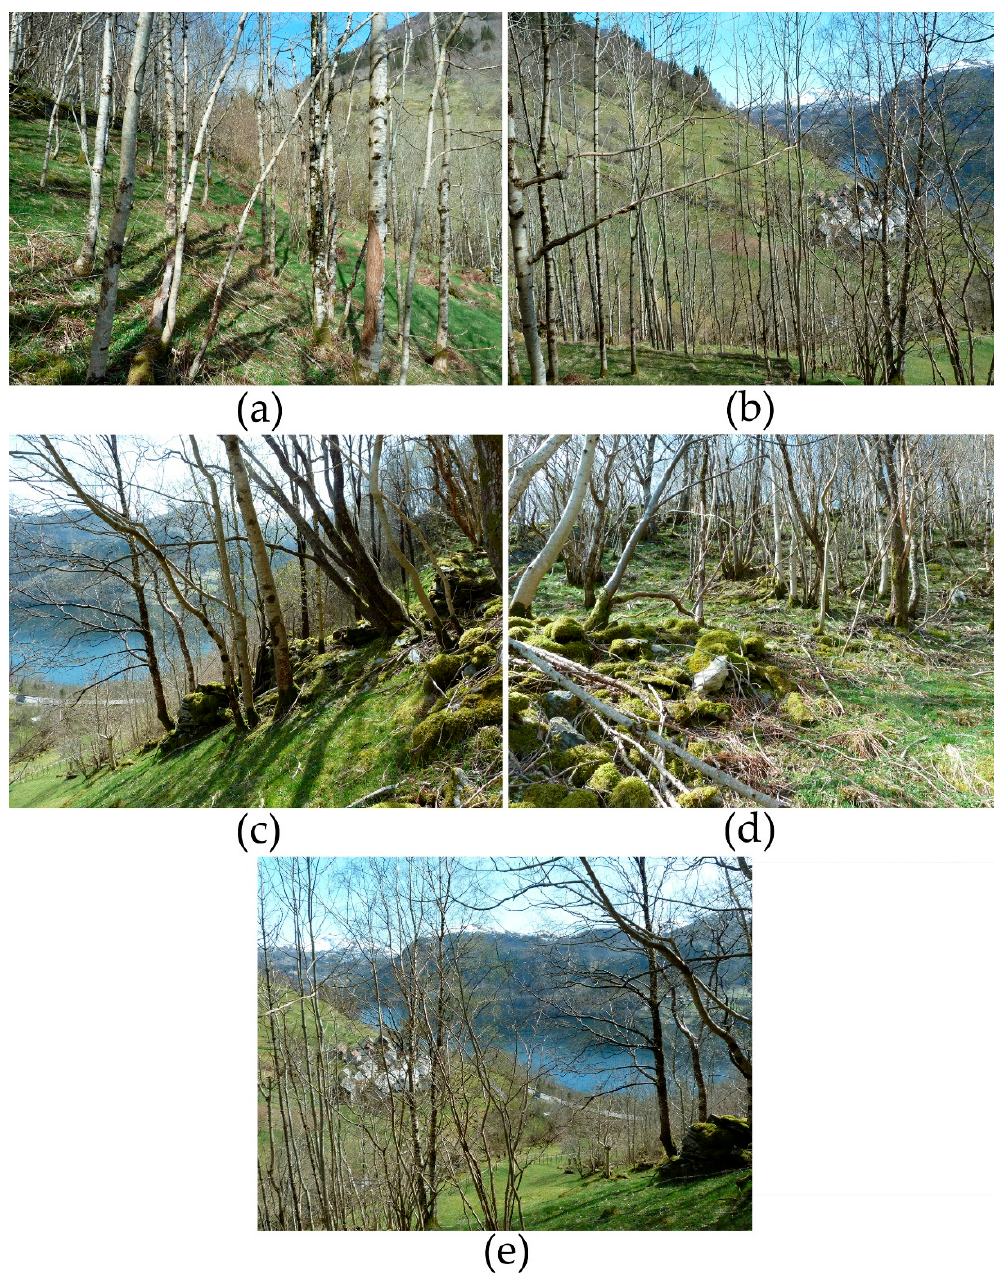
Figure 5. Photographs taken from a pre-defined (quantitative) photo-point towards north ( a ), east ( b ), south ( c ), west ( d ), and into a freely chosen direction, southeast ( e ). The photos do not show details of prominent landscape elements of defined value, but nevertheless document aspects of landscape character. Photos: W.F./NIBIO.